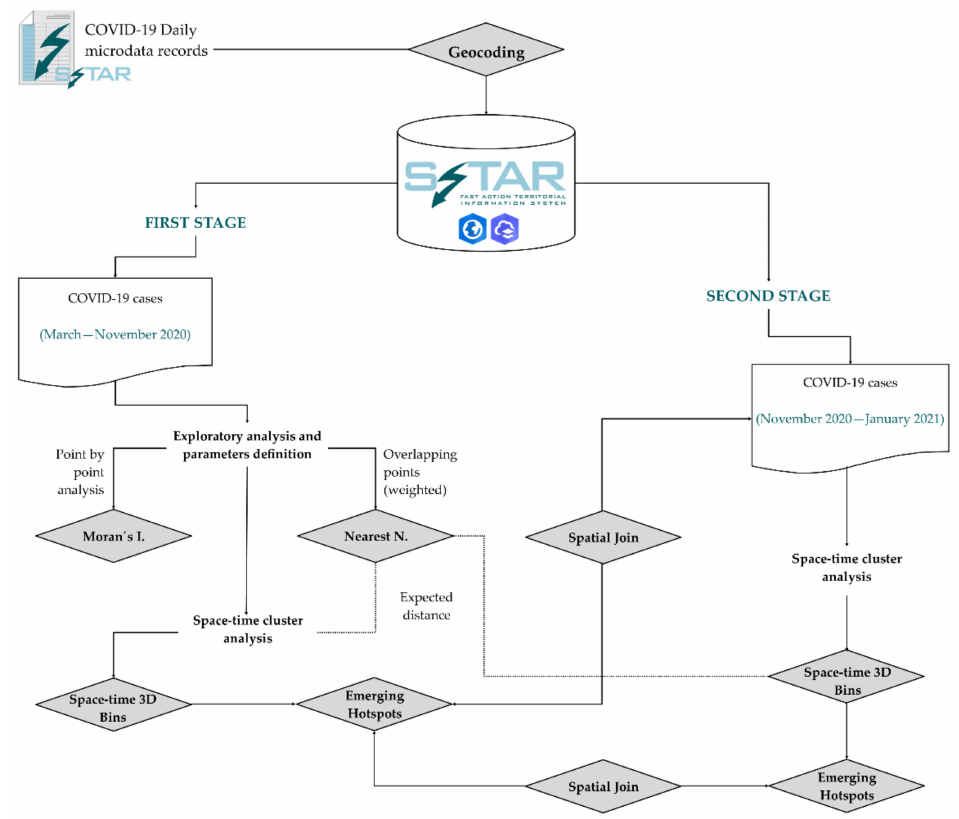
Figure 3. Methodological design of the research based on two